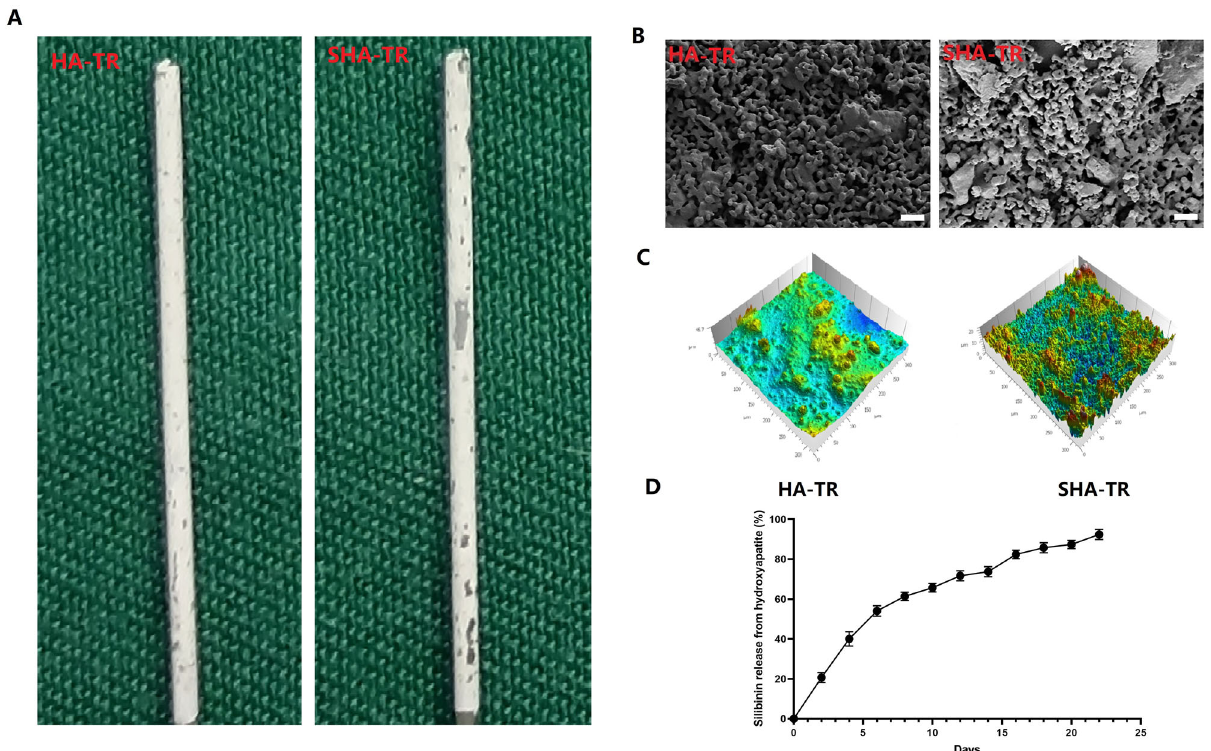
Fig. 1 The surface characteristics and SIL Release characteristics of HA-TR and SHA-TR. A Representative pictures of general view of HA-TR and SHA-TR; B : Representative pictures of higher magni fi - cation of surface characterizations of HA-TR and SHA-TR, Scale bar: